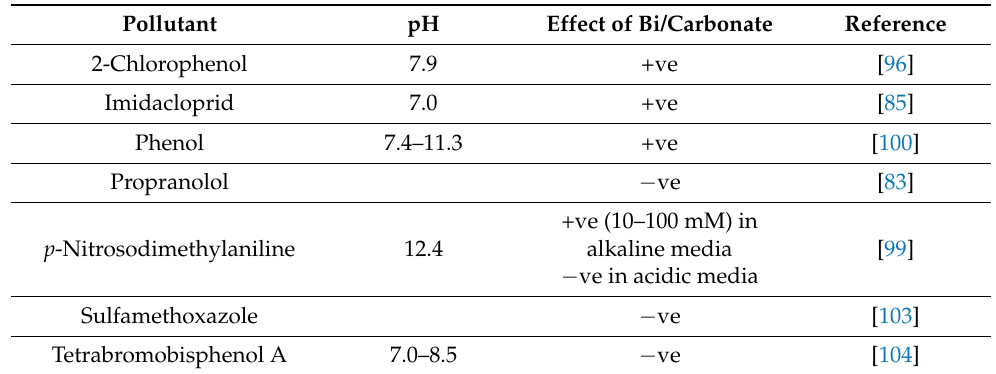
Table 4. Effect of